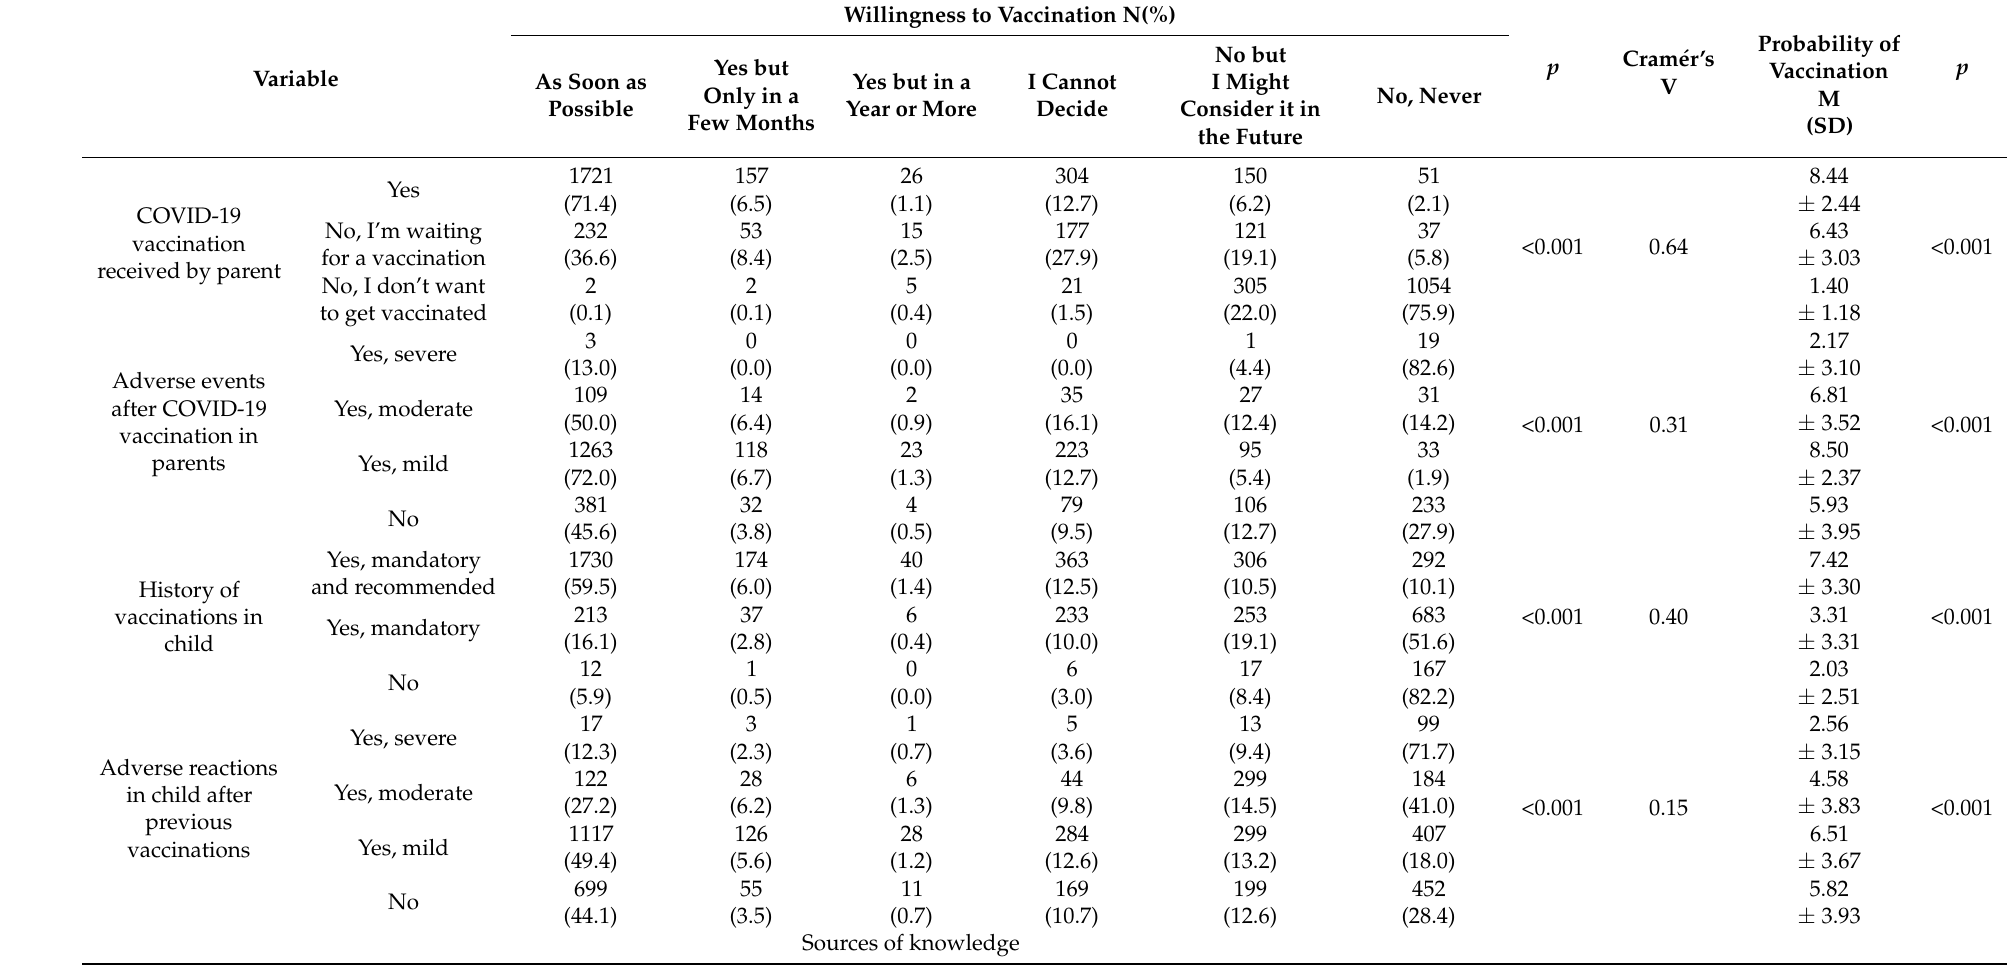
Table 5. The impact of one’s own vaccination history, sources of information and major concerns on attitudes towards getting one’s own children vaccinated against COVID-19.